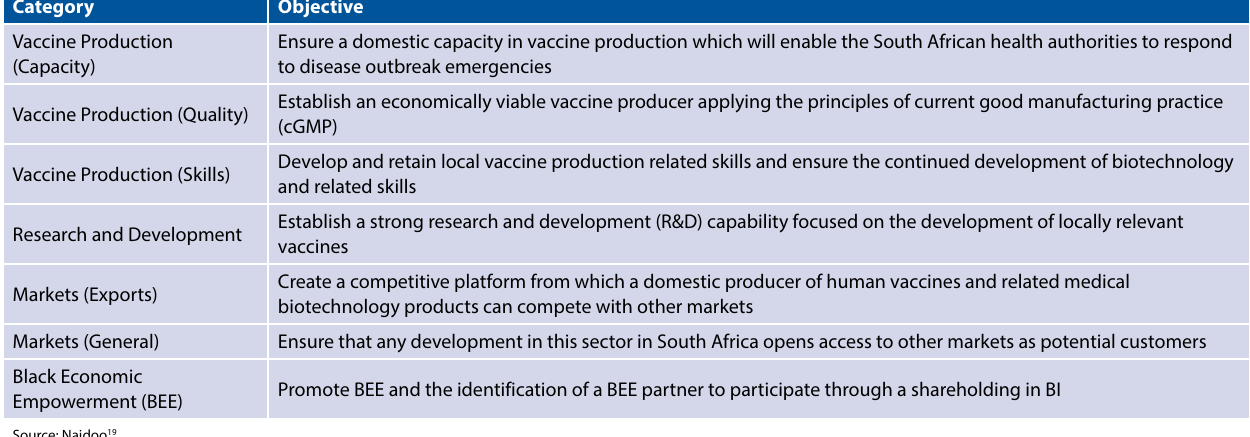
Table 1. BI-PPP objectives as listed in the Shareholders Agreement Category